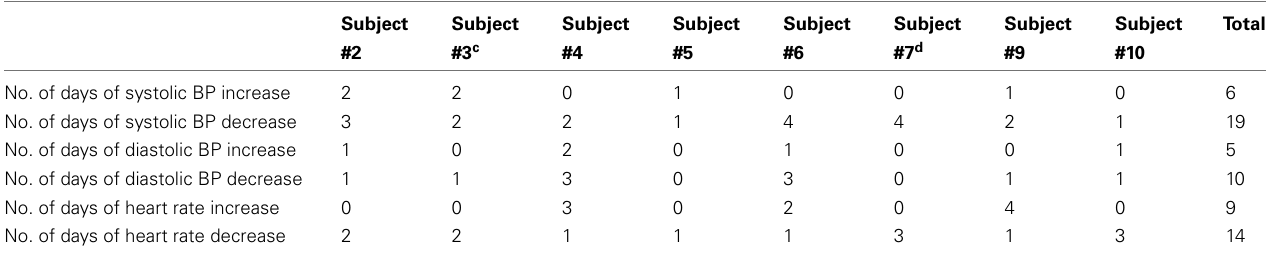
Table 4 | Clinically significant change from pre- to post-tDCS administration in systolic a and diastolic blood pressure a and heart rate b